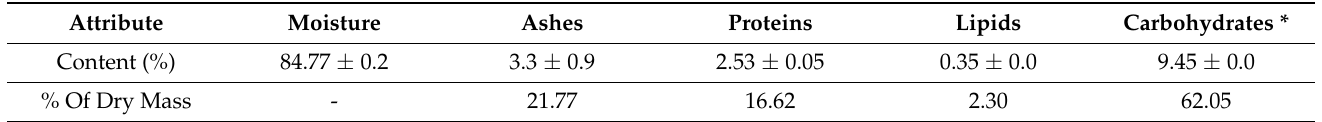
Table 2. Nutritional Composition of Cupuaçu